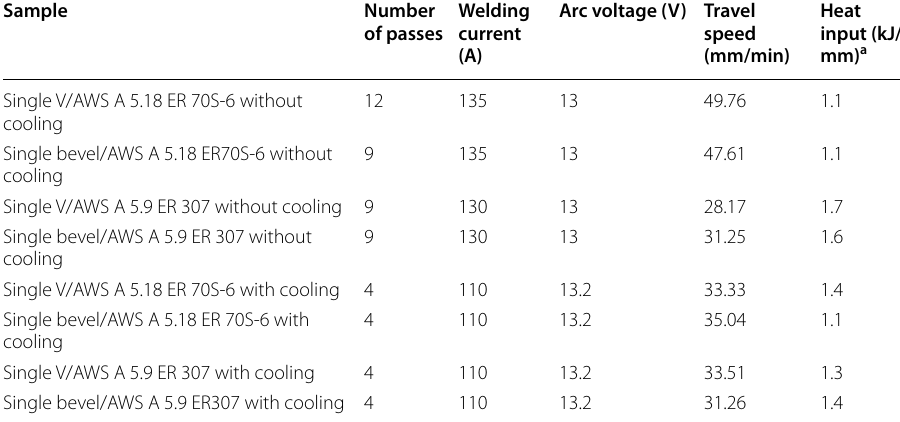
Table 5 Welding procedure parameters Sample